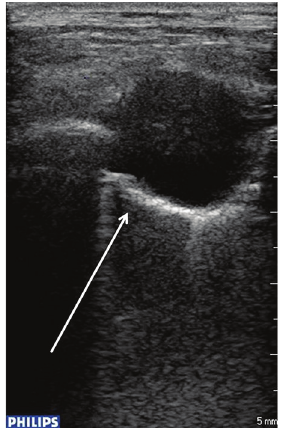
Figure 3: Rounded lesion involving the pleura. Chest ultrasonog- raphy showing a rounded lesion involving the pleura with rear- wall reinforcement and a localized alveolar-interstitial syndrome (arrow).